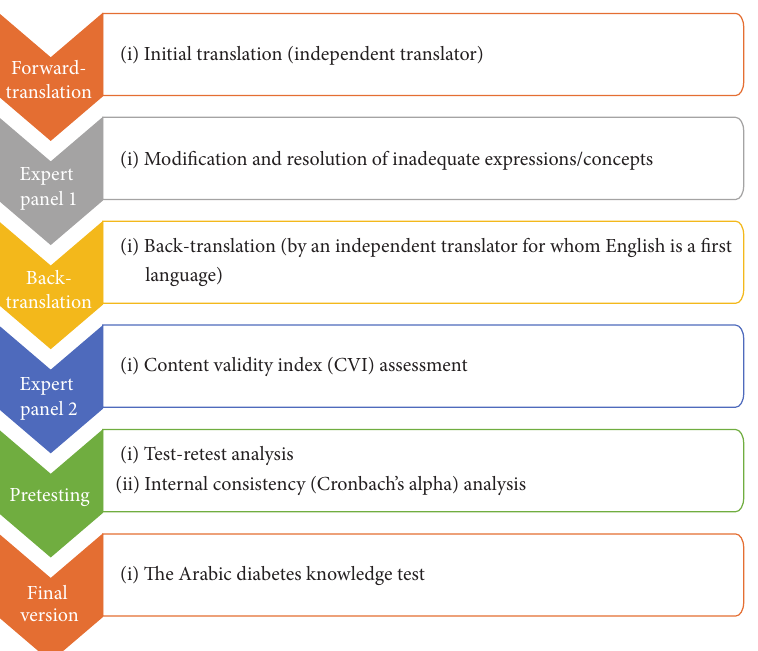
Figure 1: Flowchart depicting the processes used for the translation and validation of the